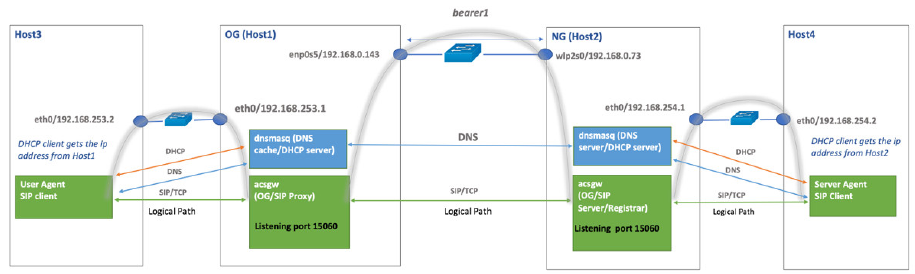
Figure 5. SIP hop-by-hop signaling process.